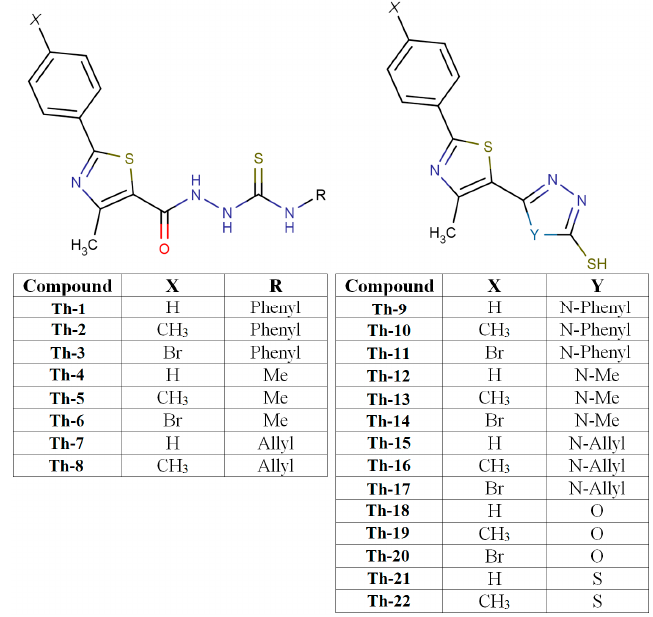
Figure 1. Structures of the studied thiazolyl-carbonyl-thisemicarbazides and thiazolyl-azole compounds—Marvin was used for drawing and displaying of chemical structures (MarvinSketch 6.3.1, 2014, ChemAxon Kft., Budapest, Hungary,